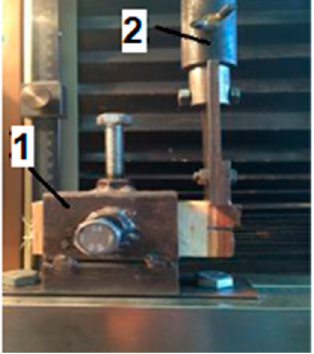
Figure 3. Depiction of the samples anchored by screws (1) and the jaw edges on the different wood/bark interfaces (2) .